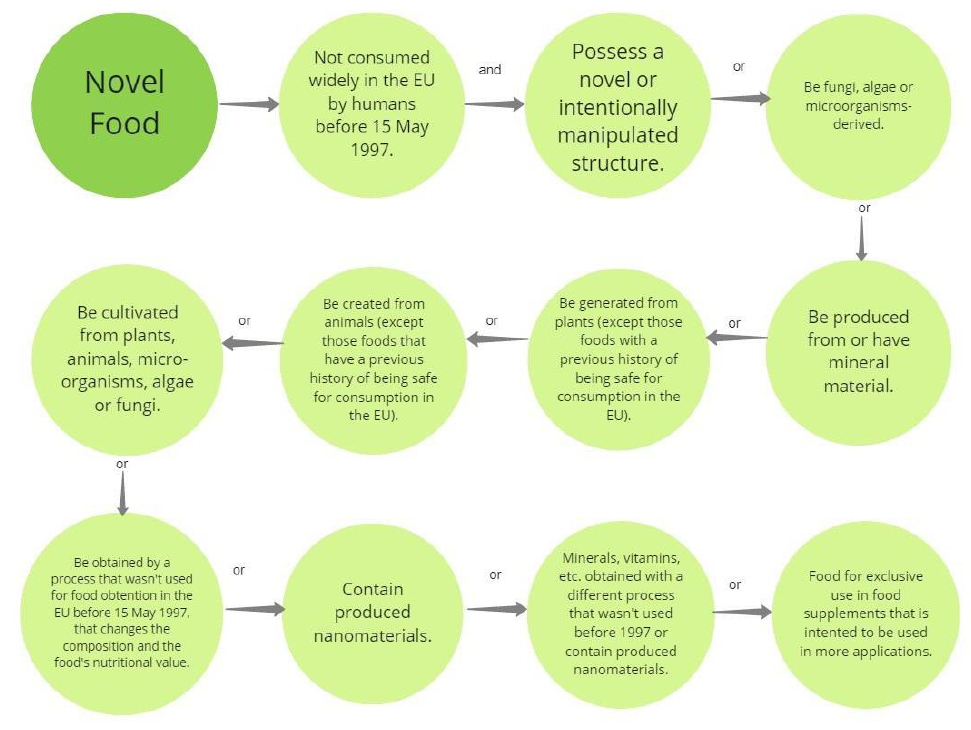
Figure 3. Aspects to consider applying the term “novel food”. Information retrieved from [98].